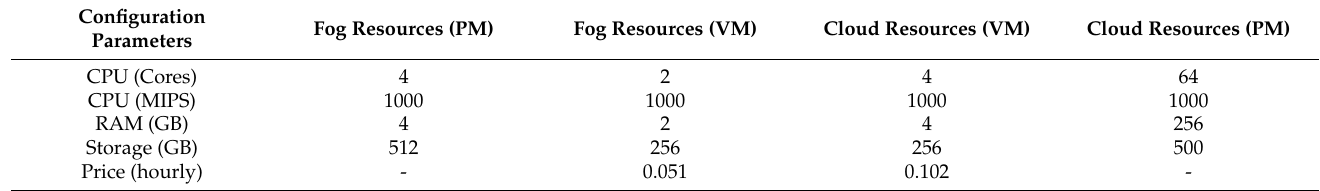
Table 2. Configuration parameters and cost of resources used in the evaluation experiments.